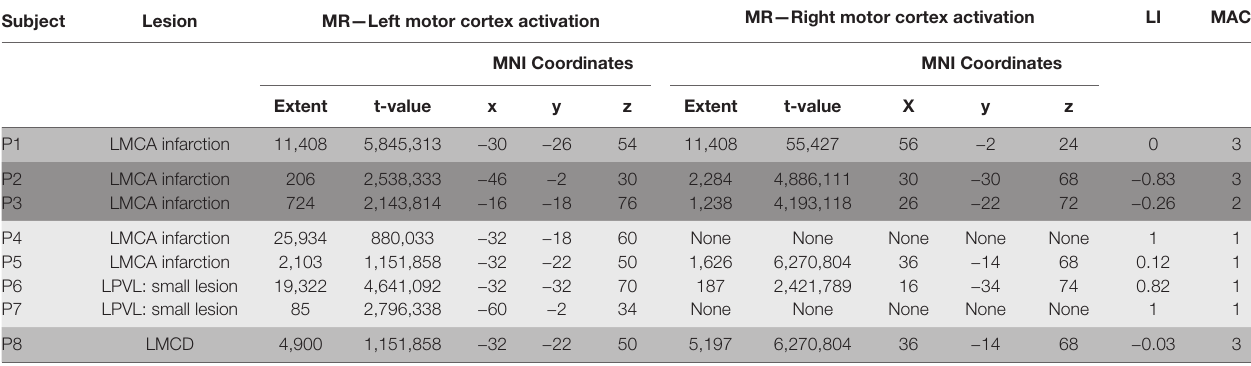
TABlE 6 | Patterns of activation in the PMC during finger tapping task with the impaired hand